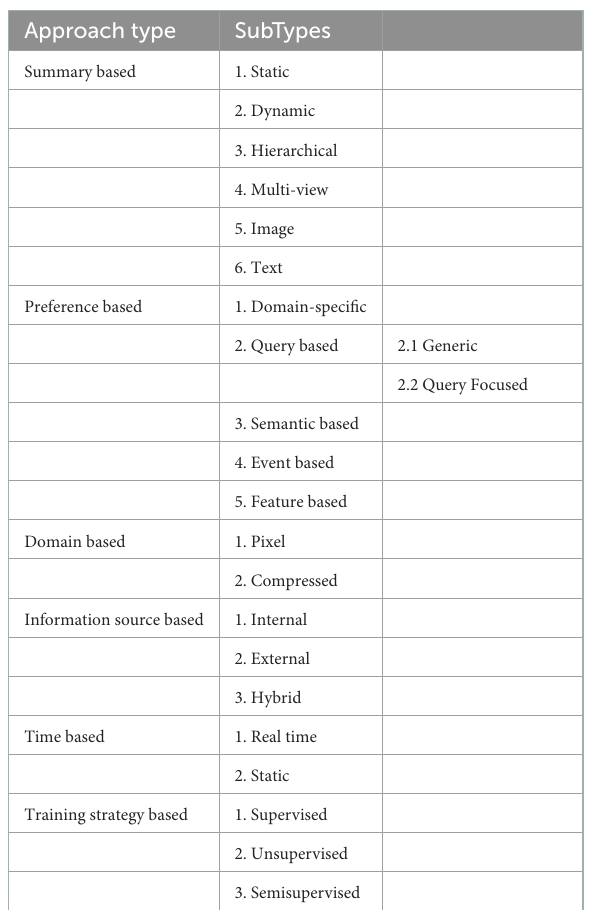
TABLE 1 Approaches of video